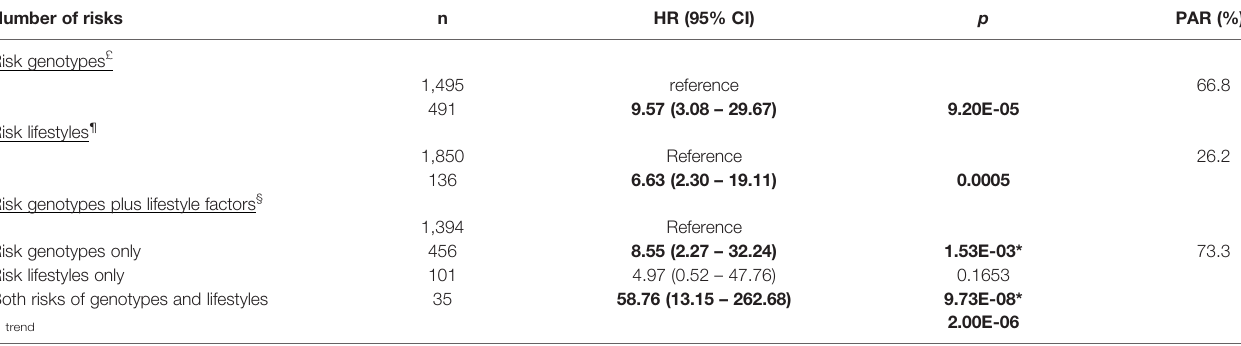
TABLE 3 | Hispanic American women: combined effect of risk genotypes and risk lifestyles on colorectal cancer risk and population-attributable risk percentage. Number of